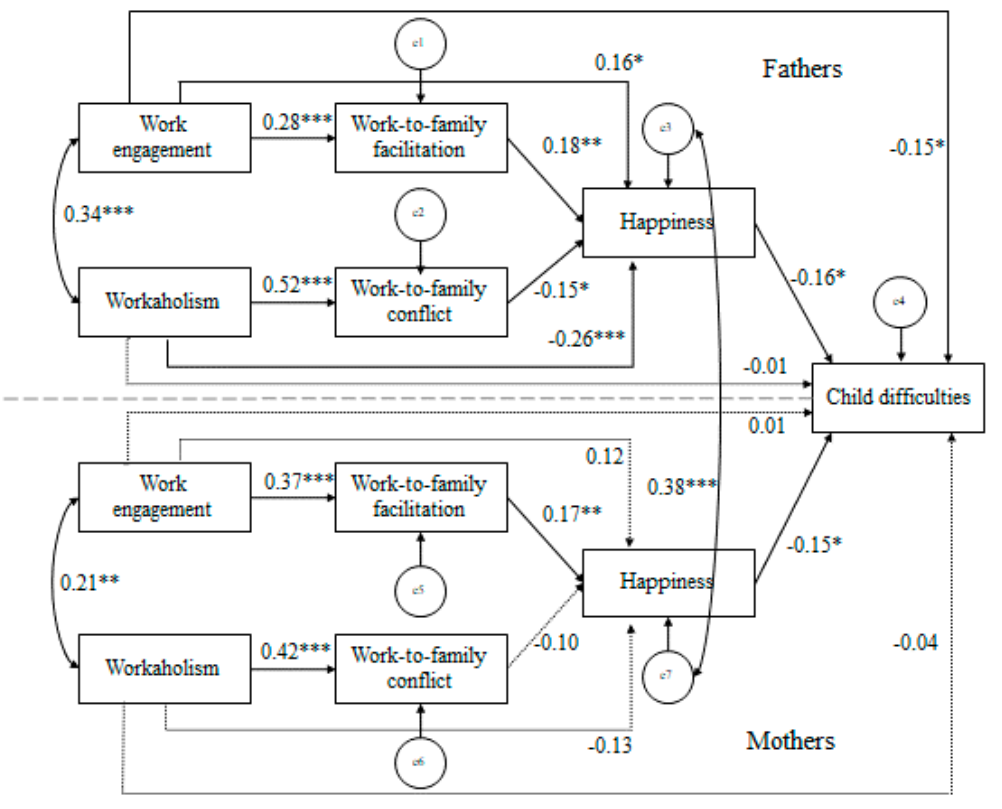
Figure 2. Standardized solution for the hypothesized model ( N = 208 families). Note: *** p < 0.001, ** p < 0.01, * p < 0.05. Dotted lines represent nonsignificant paths ( p > 0.05).